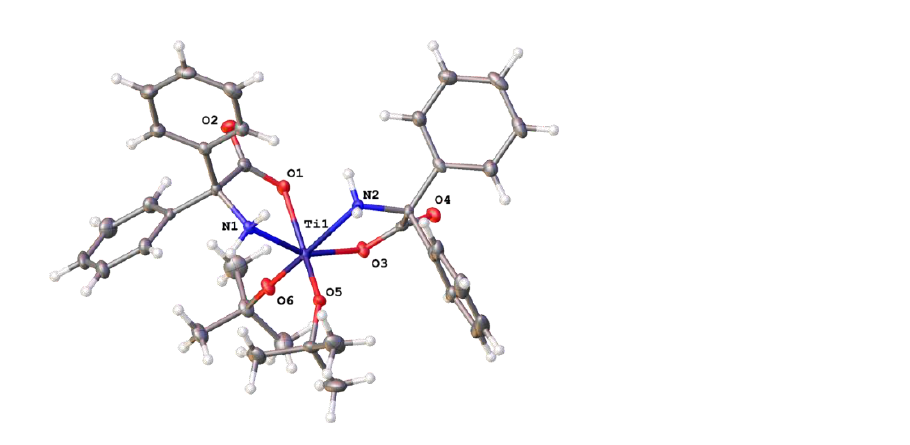
Figure 10. Asymmetric unit of 10 · 2MeCN with atoms drawn as 50% probability ellipsoids. For clarity, solvent molecules are not shown. Selected bond lengths (Å) and bond angles ( o ): Ti(1)-O(6)